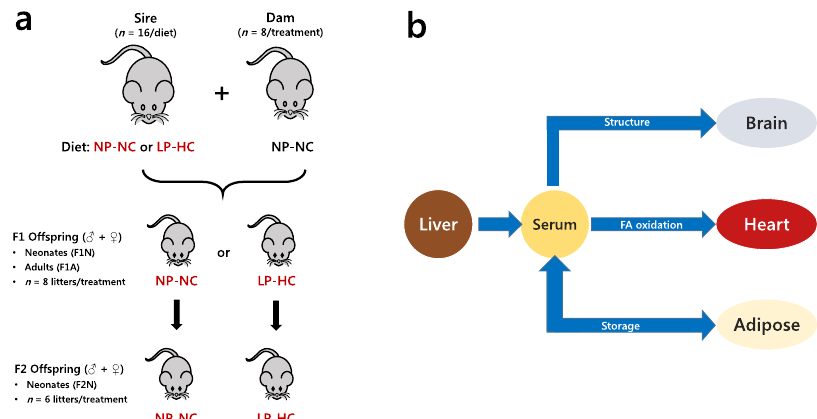
Fig. 1 The mouse model and tissues used for lipid traf fi c analysis associated with de novo lipogenesis. a Schematic representation of the mouse model showing the generation of programmed offspring across two generations. b The network that describes the lipid traf fi c associated with de novo lipogenesis from the liver to termini (CNS, heart and adipose) via the serum. The termini represent traf fi c for structural purposes (CNS), fatty acid oxidation (heart) and storage (adipose). This metabolic relationship between tissues was used as the structure of the network for all analyses in the present study. Adipose was not available for neonates and thus networks for F1N and F2N do not include this tissue. Cerebellum and right hemispheres of the brains of the F1A and F2N groups, enabling separate analysis of cortices and the cerebellum in these groups. NP-NC refers to a diet of normal protein-normal carbohydrate where LP-HC refers to a low protein-high carbohydrate diet. The NP-NC and LP-HC are the same as NN and LL groups used in earlier studies 2,15